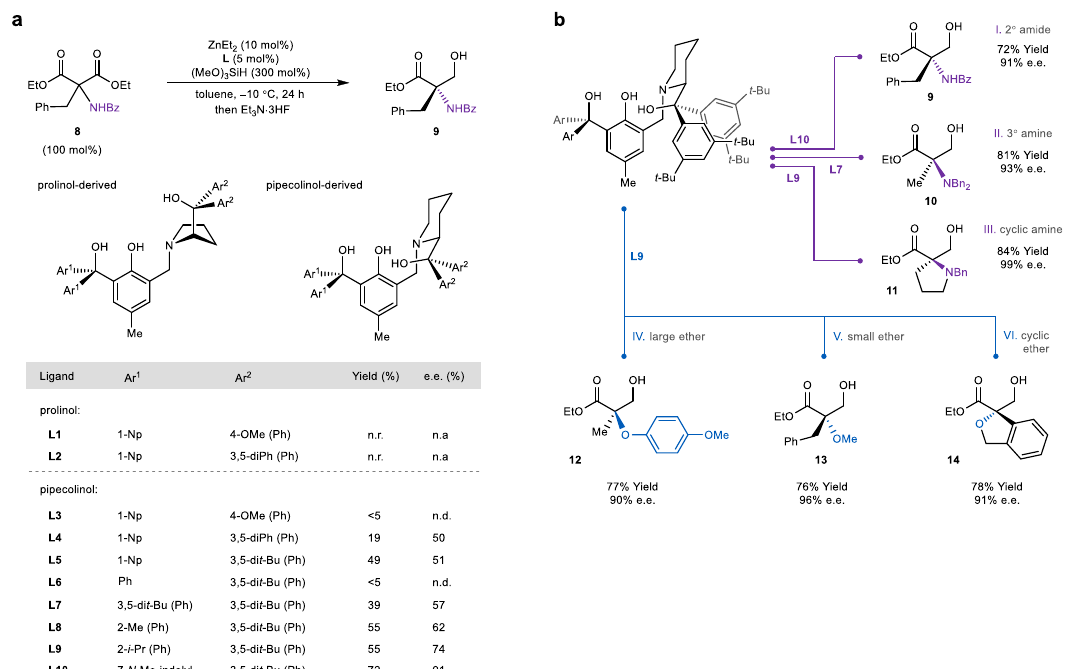
determined by comparison with a known N- Boc-protected α -amino acid after hydrolysis and protection. The absolute con fi guration of 10 was determined by comparison with a known compound after transesteri fi cation to methyl ester. The absolute con fi guration of 12 was determined by comparison with chiral citramalic acid after a sequence of derivatization (see Supplementary Fig. 255). The absolute con fi guration of 13 was determined by comparison with a known compound after deprotecting of the methyl ether. Bn